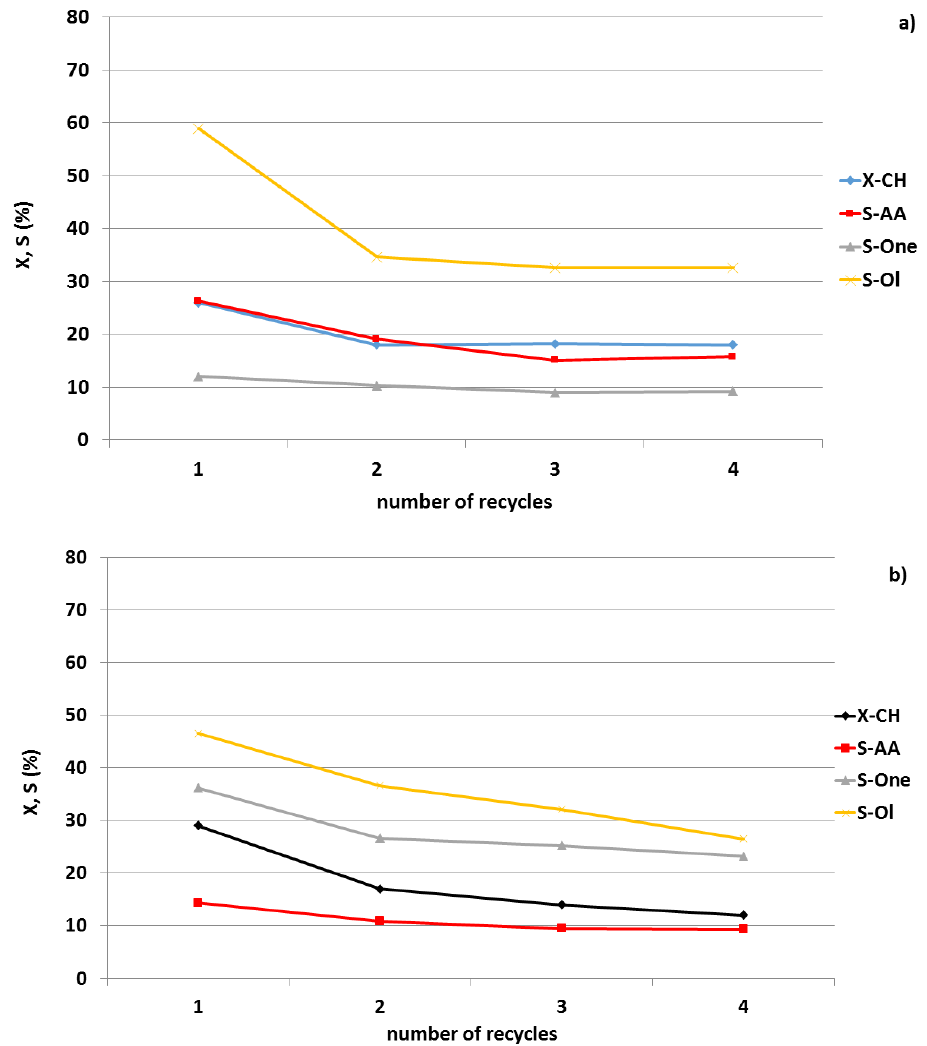
Figure 13. Recycling results of AuPd/TiO 2 ( a ) and AuAg/TiO 2 ( b ) catalysts for the oxidation reaction of cyclohexane (X—conversion, S—selectivity, CH—cyclohexane, AA—adipic acid, One—cyclohexanone, Ol—cyclohexanol; reaction conditions as in Figure 12).